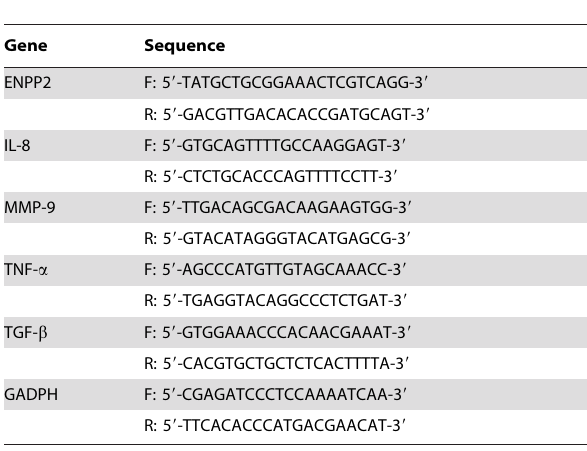
Table 2. Primer sequences used for RT 2